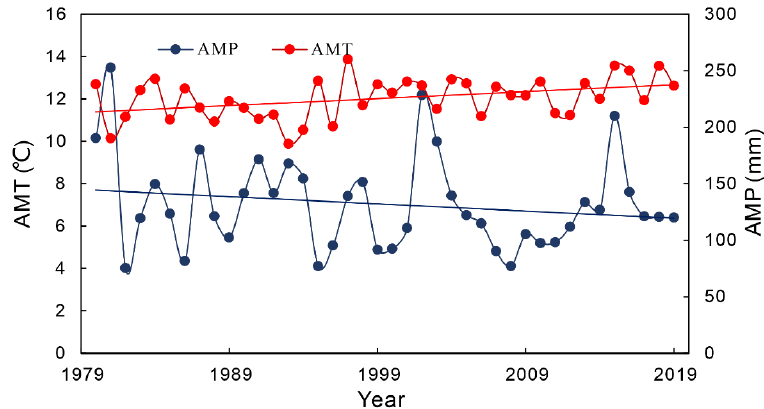
Figure 13. Changes in the annual mean precipitation and temperature measured at Nurkus Station from 1980 to 2016. Amu Darya River is the main source of water for ADD living and irrigation. Over- watering has disrupted the water system of the ADD, leading to the disappearance of an amount of lakes, followed by local climate change, which has reduced the ecosystem sta- bility of the ADD, particularly in the downstream region [7,10]. The widespread use of diffuse irrigation has caused individuals to compensate for inefficient irrigation by col- lecting large amounts of water, resulting in a reduction in the ecological water that sus- tains the ecosystems and the gradual withering of vegetation without sufficient water to support growth [9,66,67], exacerbating the land degradation. The extent of the land deg- radation followed the same trend as that of the water withdrawal from Amu Darya River. With the decline in the water withdrawal in 1990–2000 (Figure 14), the improvement in ADD land degradation was most pronounced, while, in 2000–2019, as the water with- drawal increased, the land degradation developed in a larger area than the improvement area. A more critical situation is that the reservoir built in the upper reaches of the Amu Darya River intercepted a large amount of the water [66], resulting in a decrease in the supply of ecological water downstream. The ecological effects caused by these factors were confirmed by our research: The land degradation downstream of the ADD was sig- nificantly degraded compared with the region in the study period (Figures 4 and 6). In addition, the higher levels of land degradation in the outer delta, farther from Amu Darya River, were likely caused by the lack of water supply to the ecosystem and the difficulties in the land management in the transboundary area [46,68]. This finding indicates that, to alleviate the ADD land degradation and the ecological crisis in the Aral Sea basin, further effort and cooperation is necessary in the rational allocation of water resources.